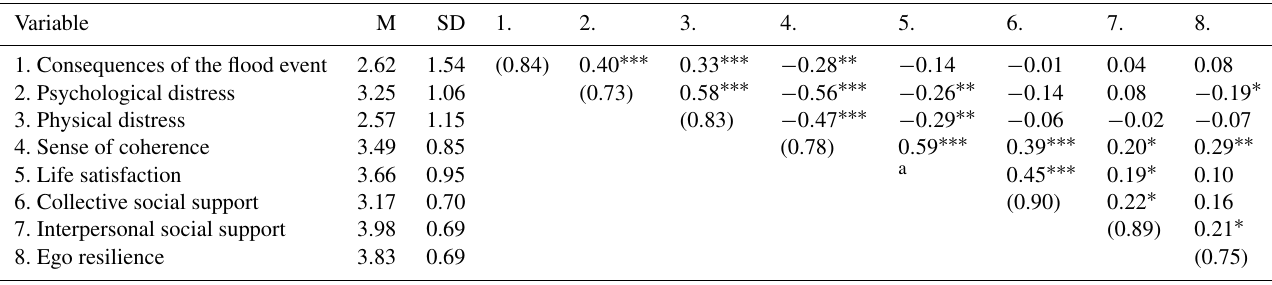
Table 1. Mean, standard deviation, Cronbach’s alpha coefficient (provided in parentheses) and inter-scale correlations between variables.